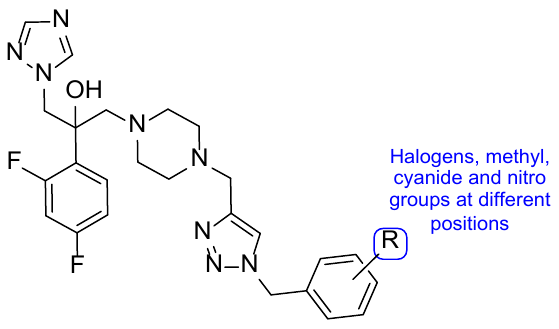
Figure 16. Chemical structure of the tested triazole compounds [96].